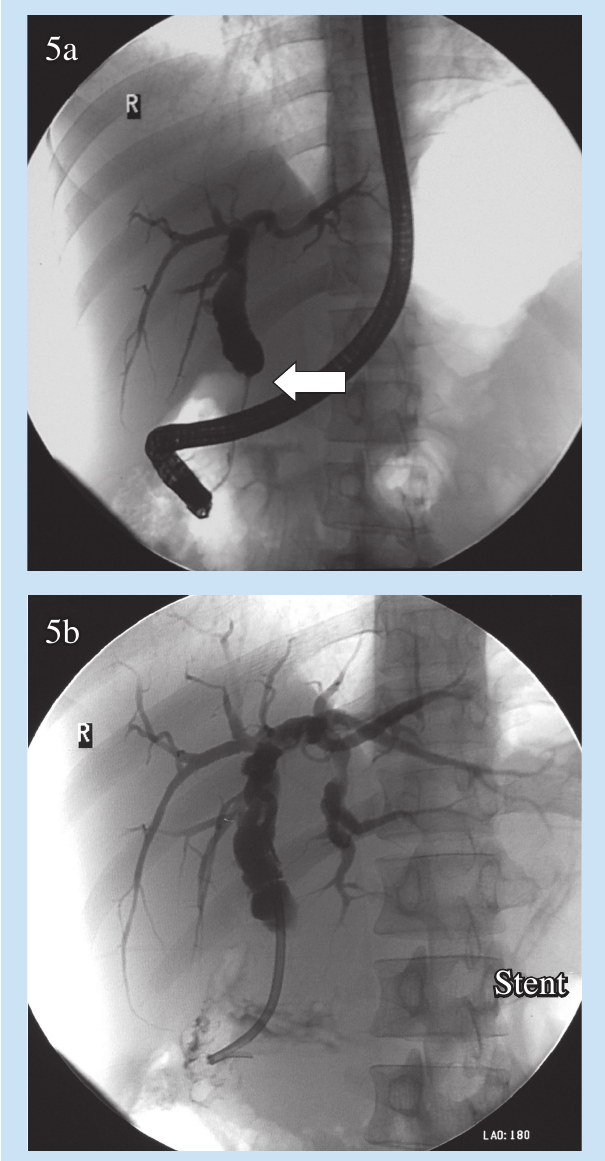
Figs 5a and b. ERCP (LAO view) demonstrating stenosis (white arrow) of the common bile duct due to a tumour in the head of the pancreas. a: Before stenting, b: after inserting a